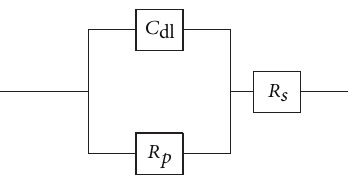
Figure 11: Equivalent circuit used to fit the impedance spectra.